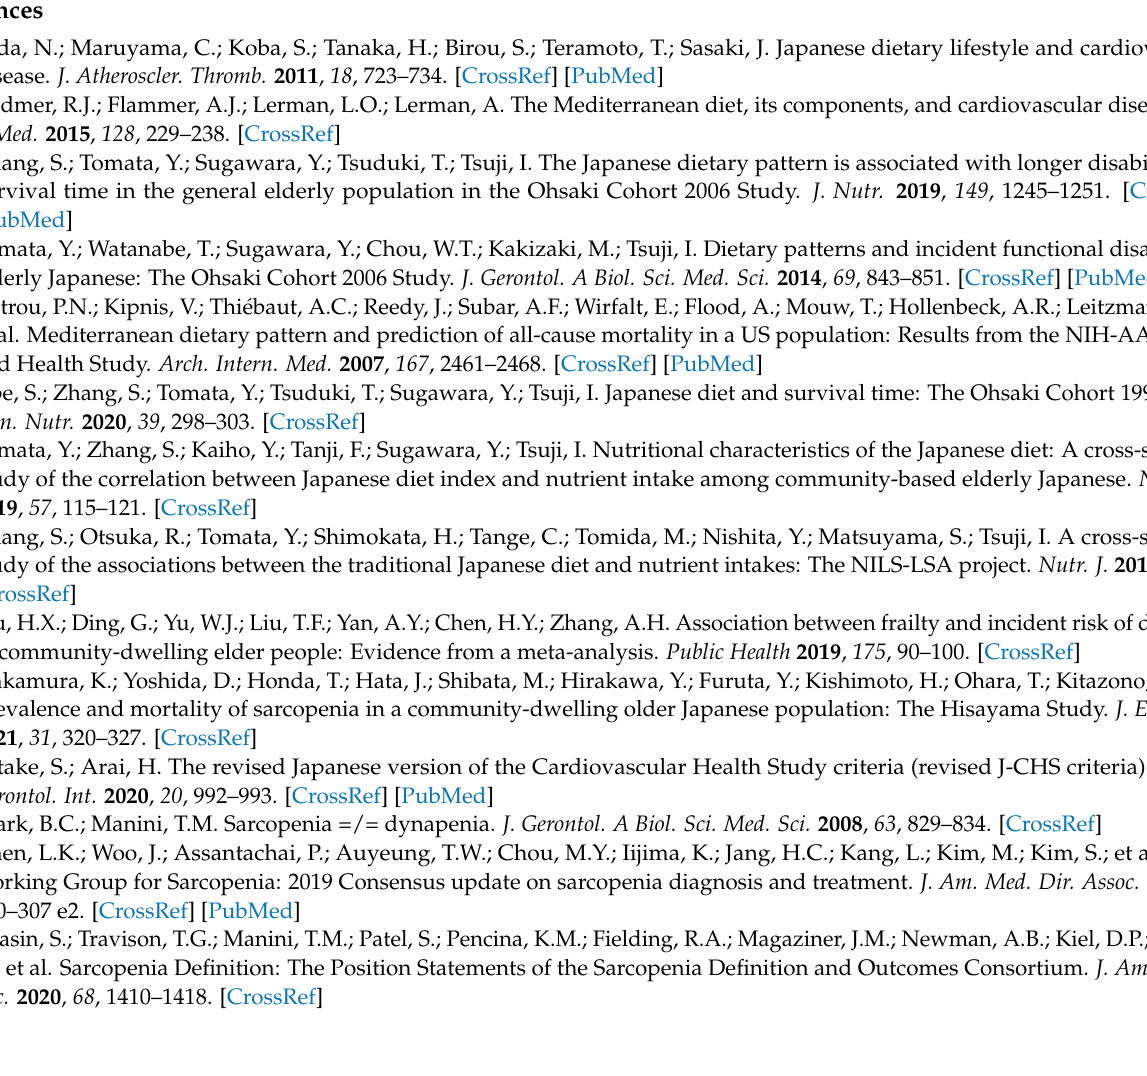
in the rJDI12 score quartile range. Table S2: Characteristics of sex discrimination in the aMed score quartile range. Table S3: Comparison of two dietary patterns and nutrient intakes. Table S4. Relationship between the constituent nutrients of rJDI12 and muscle weakness. Table S5. Relationship between the constituent nutrients of aMed and muscle weakness. Table S6. Relationship between the combination of adherence to two dietary patterns and muscle